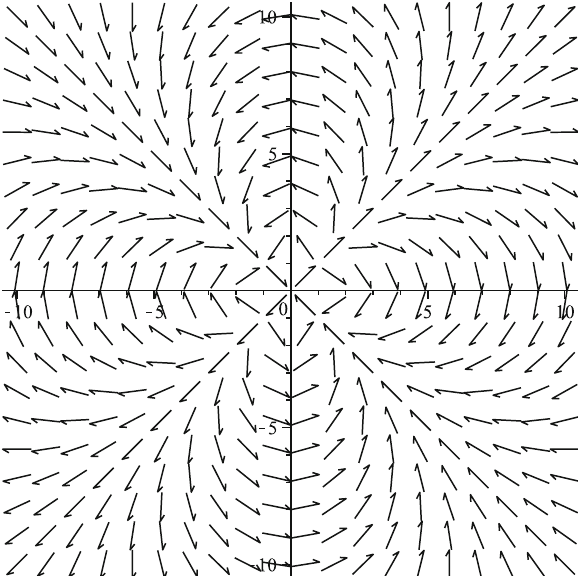
Fig. 1 Plot for the force obtained from (18), with V = V x ˆ x and U = U y ˆ y . Vertical axis is a y and horizontal axis is a x